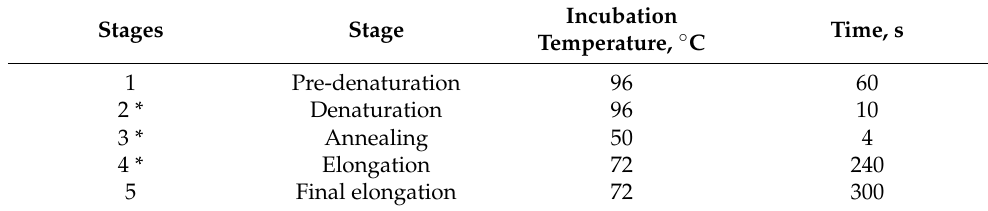
Table 3. Parameters of sequencing reaction